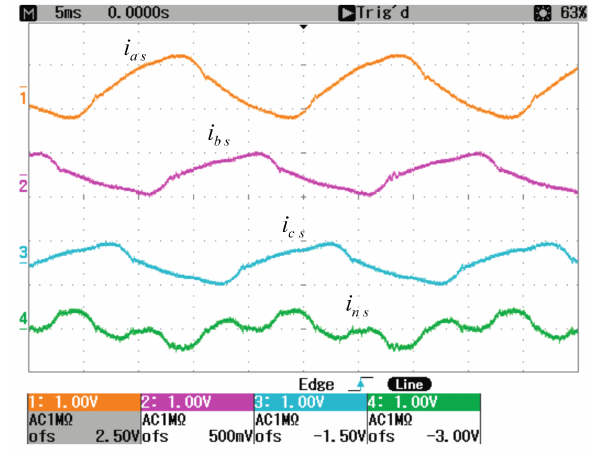
Figure 8. Power network currents after compensation with